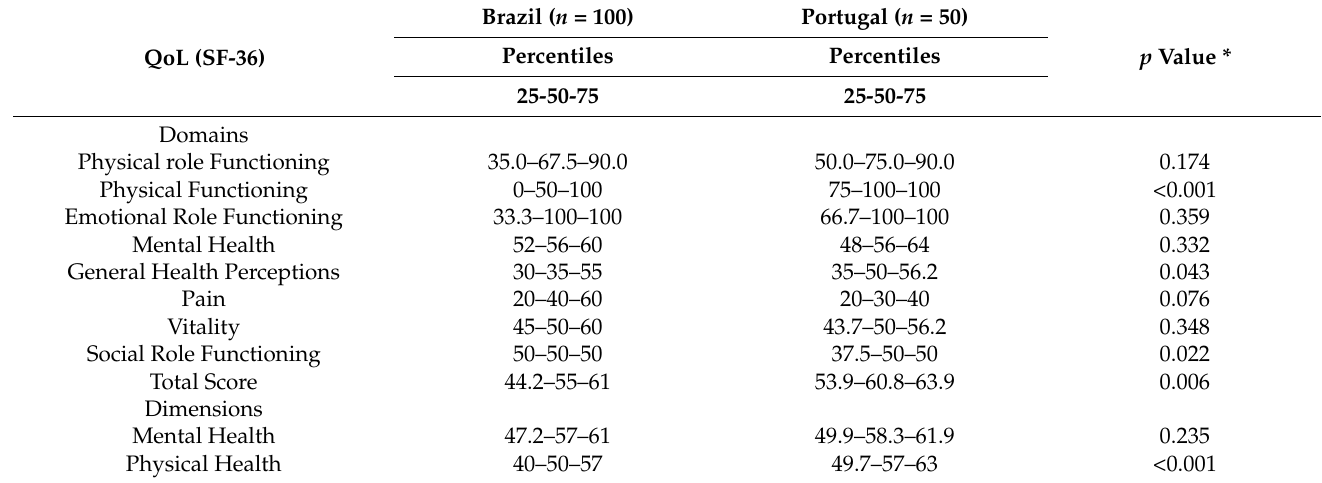
Table 2. Quality of life differences between Brazil and Portugal.